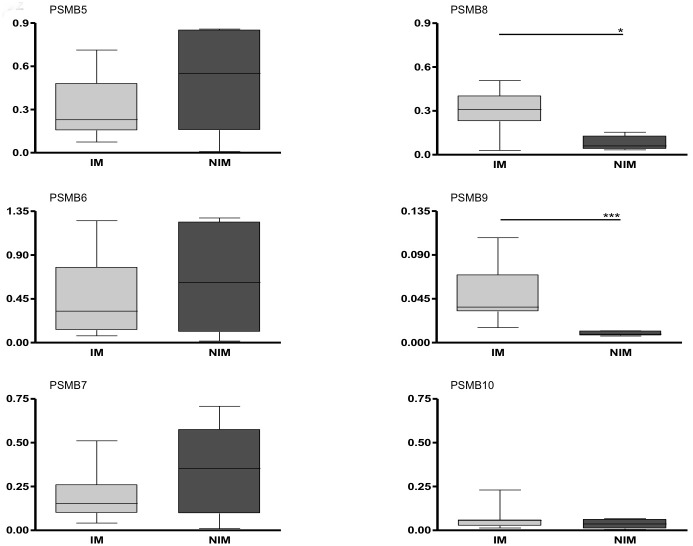
Expression of catalytic proteasomal subunits in muscle:Gene expression analysis of constitutive and immunoproteasomal subunits (PSMB5–10) in muscle biopsies of patients with inflammatory myopathies (IM) and patients with non inflammatory myopathies (NIM). Data are shown as relative expression normalized to beta actin. Box plots indicate percentiles 0, 25, 50, 75 and 100. Groups were compared by Mann-Whitney U test and statistical significance is indicated for p<0.05 (*), p<0.01 (**) and p<0.001 (***). Comparing to NIM, mean relative expression levels in IM revealed 4-fold for PSMB8 [0.302±0.139 and 0.075±0.041] and about 5-fold increase for PSMB9 [0.049±0.029 and 0.009±0.002] but less than 2-fold for PSMB10 [0.065±0.064 and 0.036±0.022].